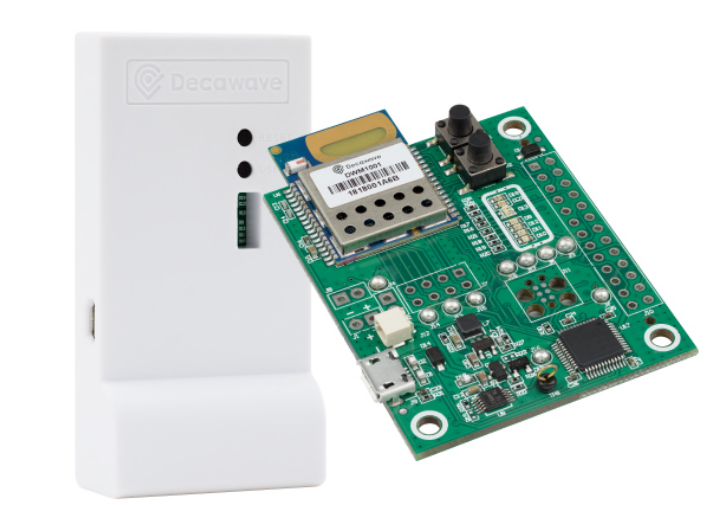
Figure 1. Configurable UWB module (DWM1001DEV) in the MDEK1001 evaluation kit from De- cawave (the kit contains 12 such modules); left: housing; right: DWM1001 circuit board with the antenna on top